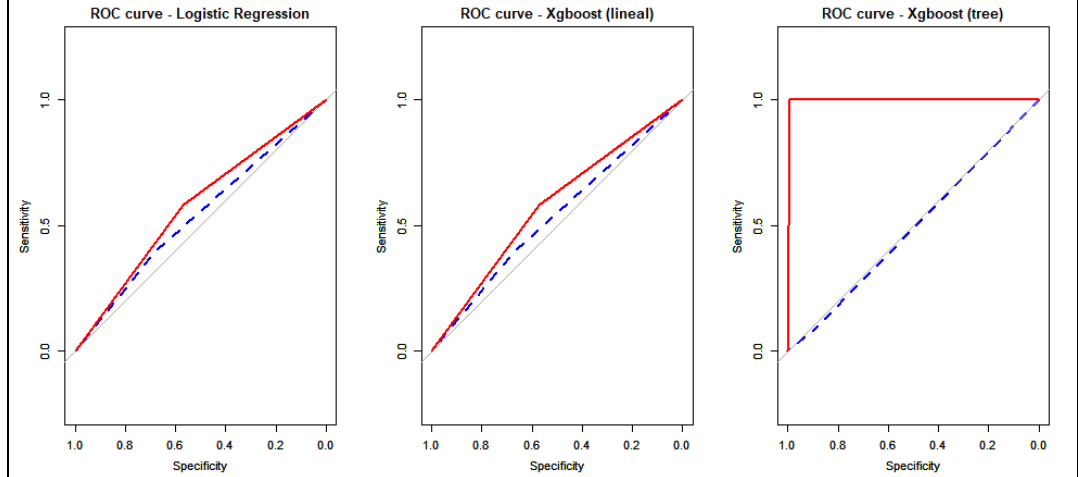
Figure 2. The receiver operating characteristics (ROC) curve obtained using the three methods on the training and testing samples. The red solid line represents the ROC curve obtained by each method in the training sample, and the blue dotted line represents the ROC curve obtained by each method in the testing sample. The area under the curve (AUC) is 0.58 for the training sample (T.S) and 0.49 for the testing sample (Te.S) when logistic regression is used; 0.58 for the T.S and 0.53 for the Te.S when XGBoost (linear booster) is used; and, 0.997 for the T.S and 0.49 for the Te.S when the XGBoost (tree booster) is used.